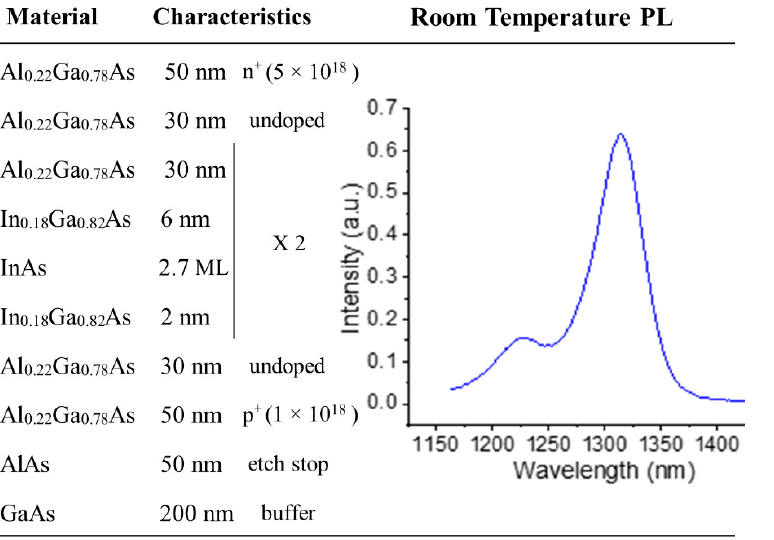
Figure 14. The epitaxial structure of the optimized QD laser stack with a total III–V thickness of 236 nm and room temperature PL. For the InAs QDs layer thickness, ML denotes monolayers. 236 nm and room temperature PL. For the InAs QDs layer thickness, ML denotes